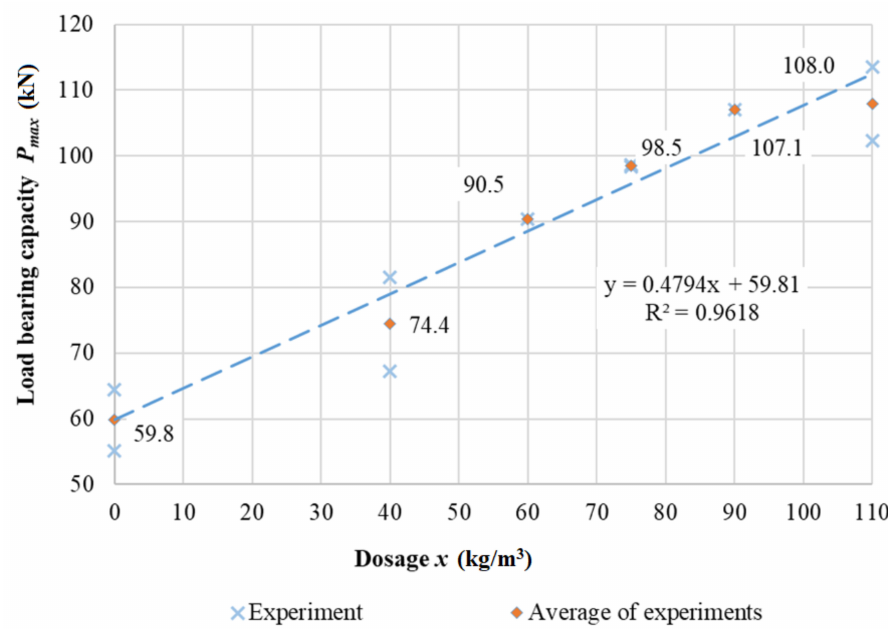
Figure 19. Load-bearing capacity—reinforced concrete beam without shear reinforcement. Span: 600 mm.